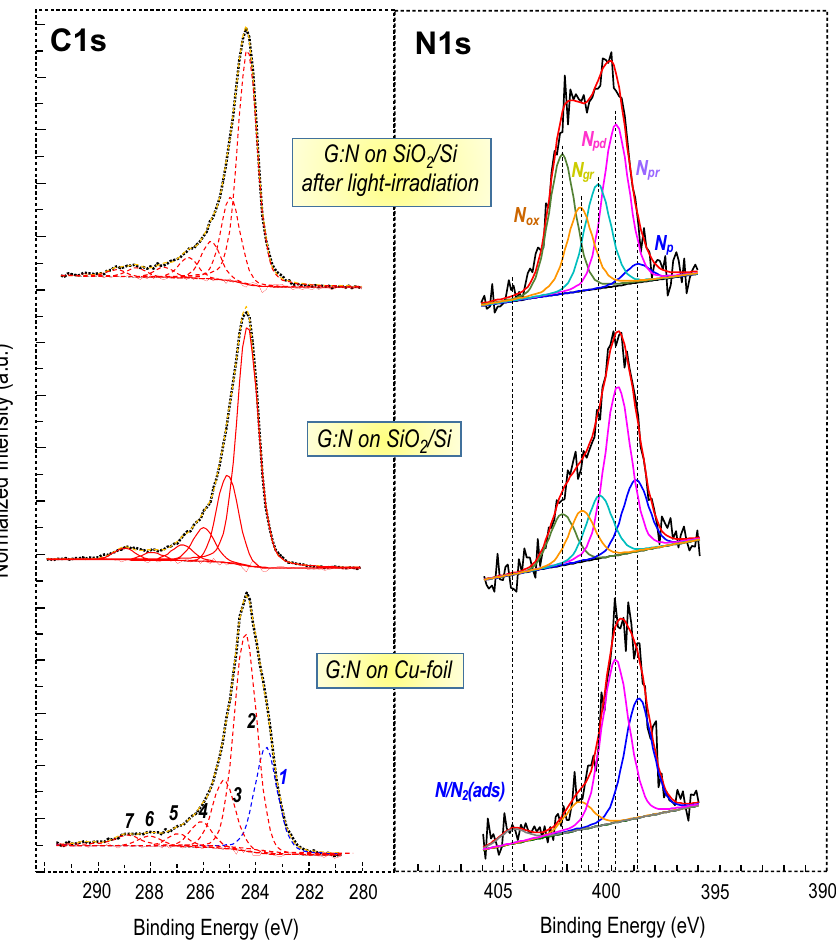
Figure 3. High-resolution (0.9 eV) C1s and N1s XPS spectra for single layer graphene as grown on Cu-foil, and transferred on SiO 2 /Si substrate before and after irradiation with Xe-lamp. C1s -spectra deconvolution of G:N on Cu foil is performed with seven peaks at 283.6 (1), 284.4 (2), 285.2 (3), 286.0 (4) 286.9 (5), 287.9 (6), 288.8 eV (7) that can be correlated to carbon atoms in the following configurations: C segregated in the Cu foil, C sp 2 , C–OH, C = N, C–O–C, C = O and O = C–O. However, after transferring on SiO 2 /Si and light irradiation, besides the disappearance of the component (1), peaks deconvolution slightly change because of introducing